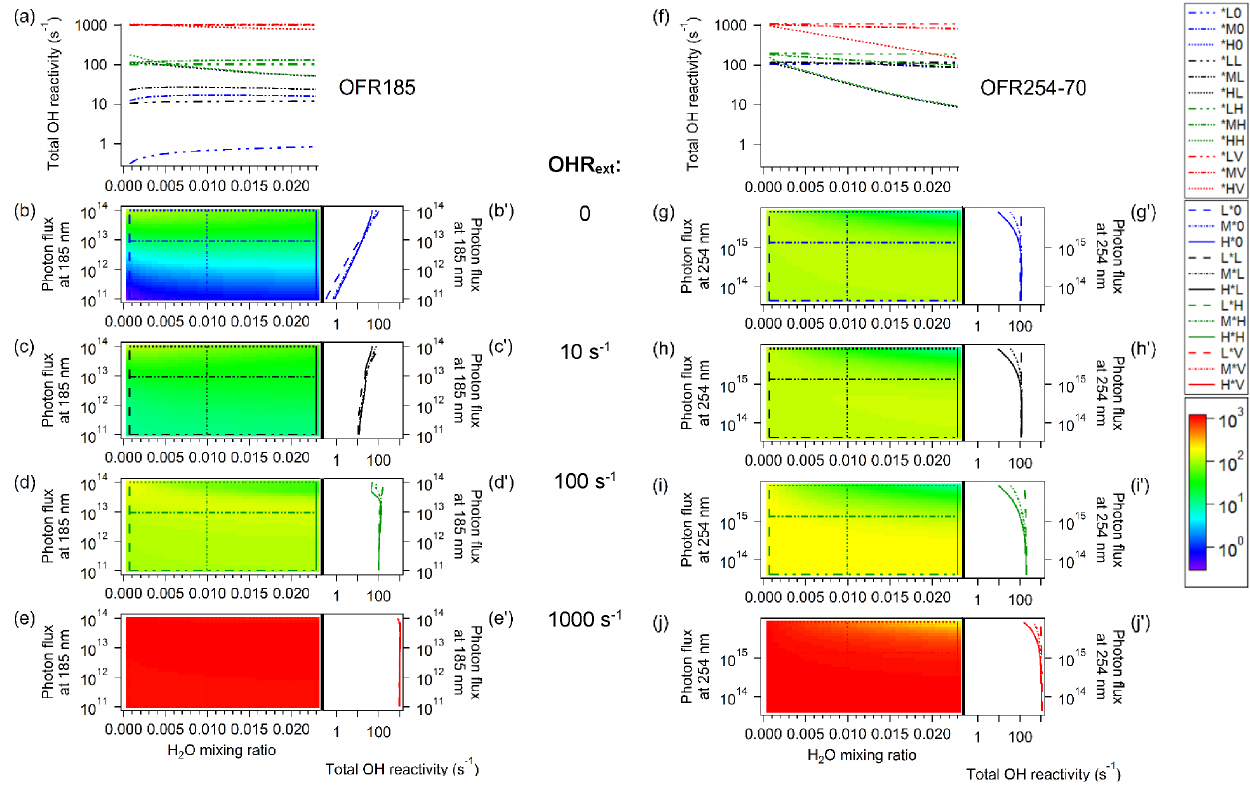
Figure 4. Total OH reactivity (in s − 1 ) vs. the same parameters and in the same format Fig.